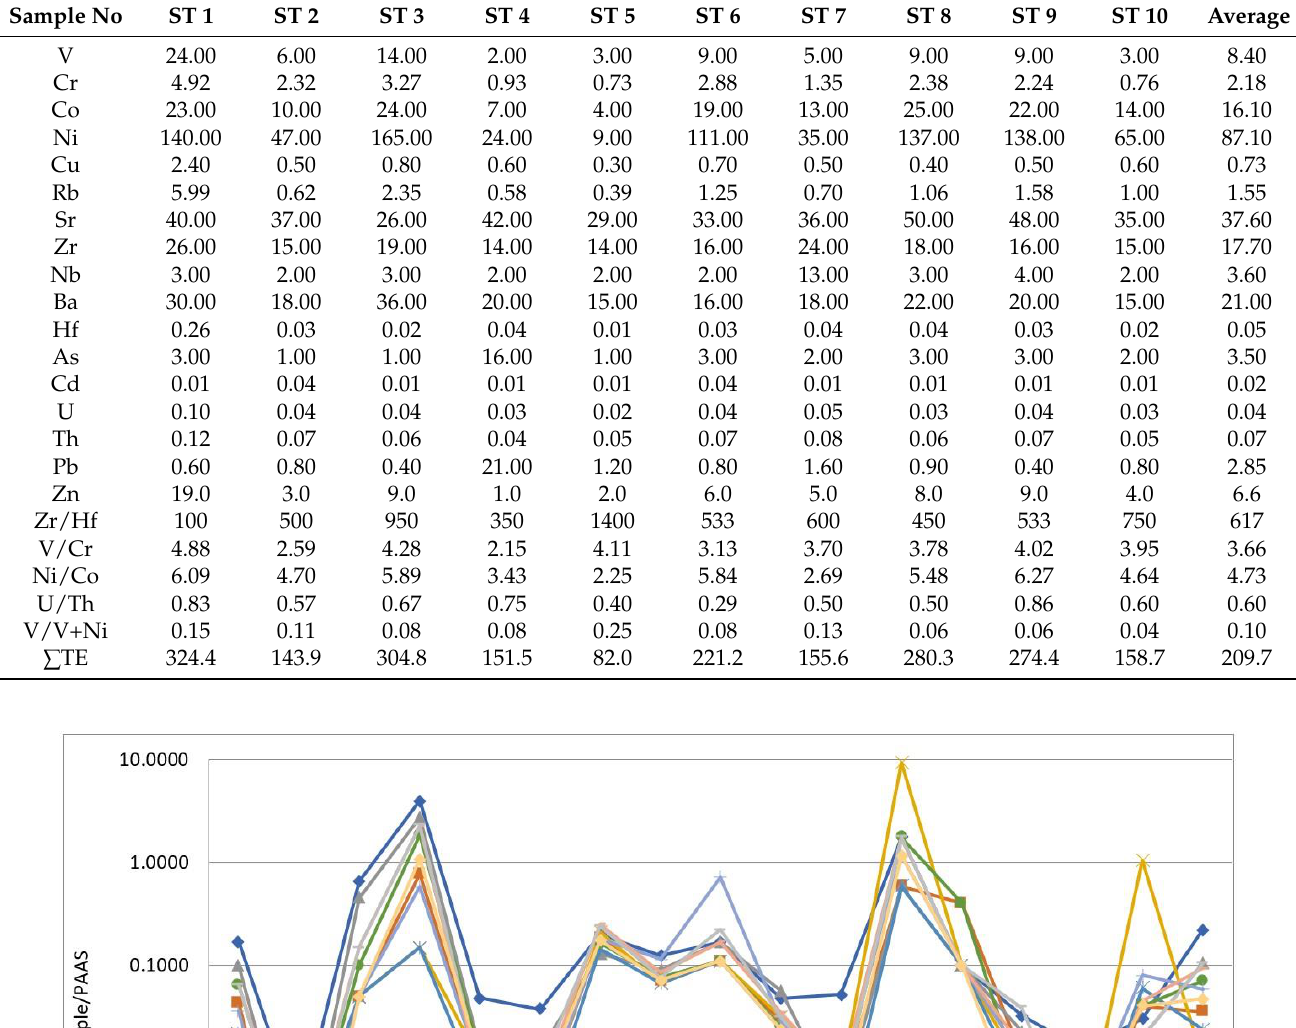
Table 3. Trace element contents of the stromatolites from Lake Salda, in parts per million (ppm; µ g g –1 ).